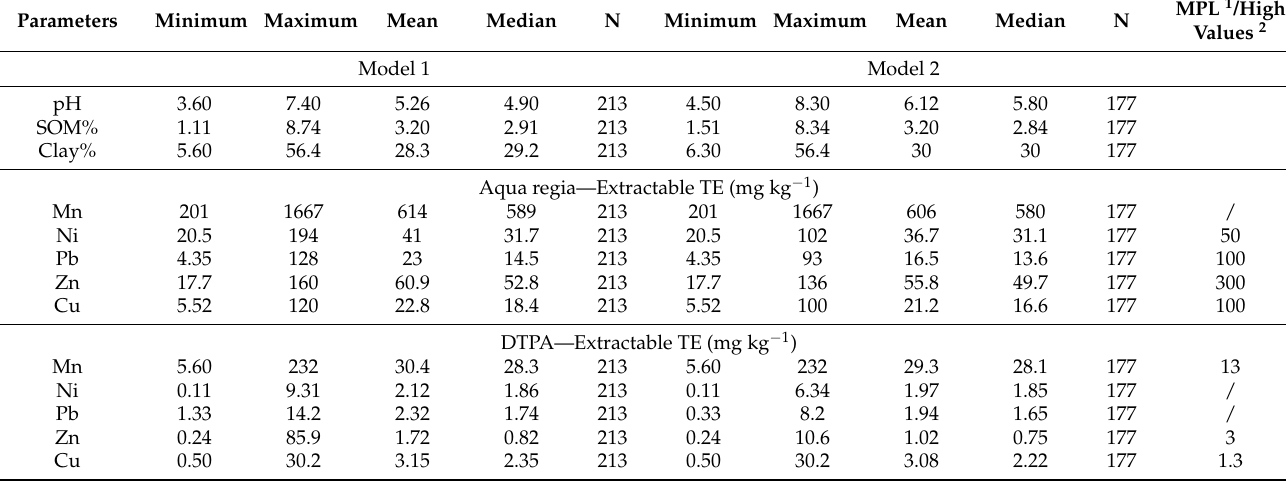
Table 1. Descriptive statistics of the physicochemical properties of the soil samples tested: Minimum, Maximum, Mean, Median and N (number of soil samples tested) for model 1 and 2. Parameters Minimum